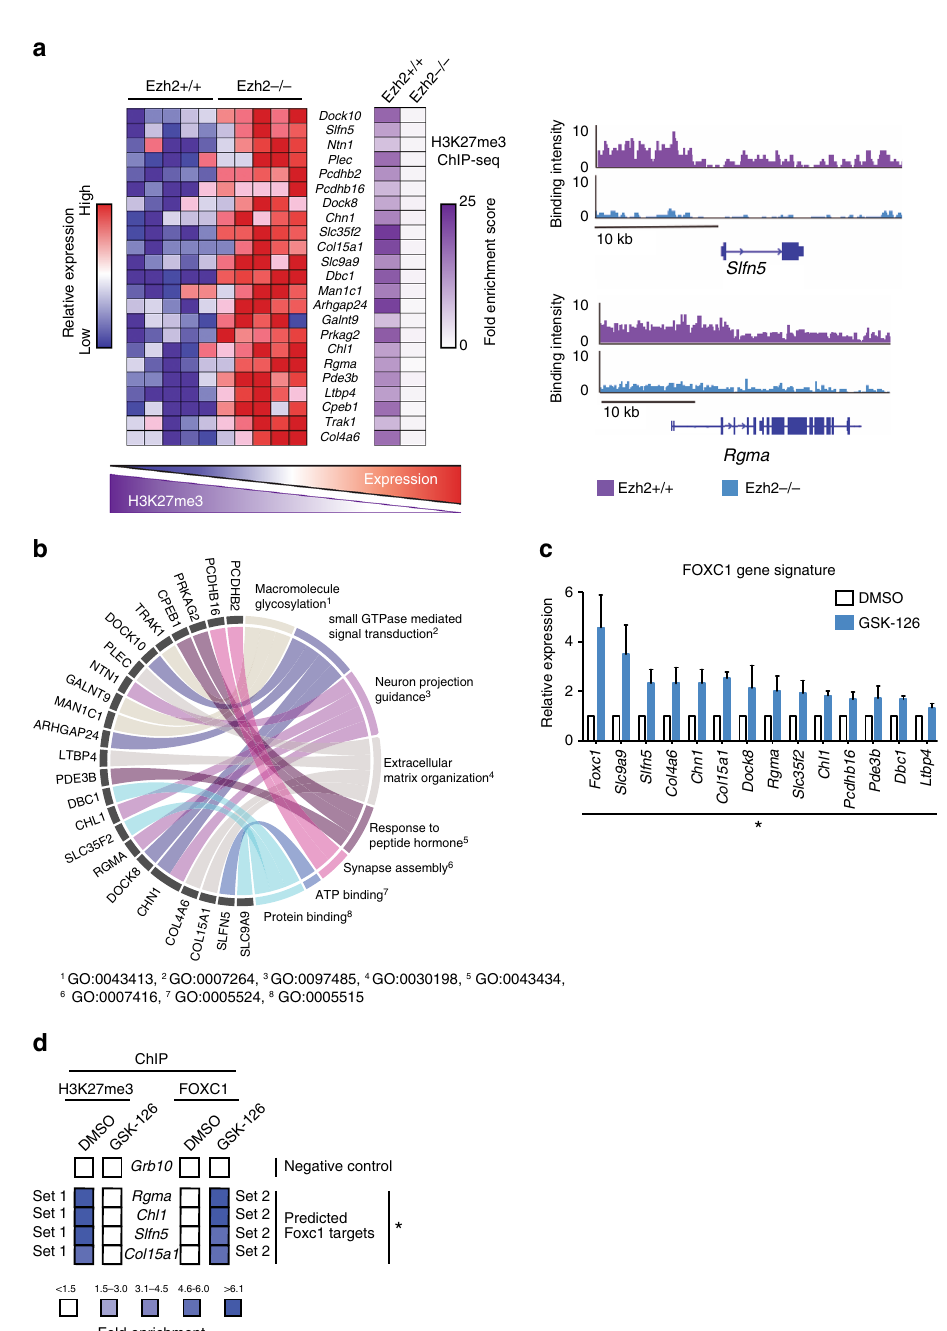
Fig. 4 Identi fi cation of anti-metastatic targets repressed by Ezh2. a Increased expression of Foxc1 predicted target genes coincides with reduced H3K27me3 enrichment status in Ezh2 − / − versus Ezh2 + / + tumours. Right panel shows a comparison of H3K27me3 binding intensity between Ezh2 + / + and Ezh2 − / − tumours for two known targets of FOXC1 activation, taken from the IGV browser. b Chord diagram of upregulated Foxc1 targets and their associated GO Biological Terms. The ChIP experiment is re fl ective of three different PyVmT cell lines. c Quantitative RT-PCR analysis of Foxc1 targets in PyVmT cells treated with GSK-126 (2 μ M for 72 h) or DMSO (vehicle). Data is an average of experiments performed in three different PyVmT cell lines. * p < 0.05 ( d ) Chromatin immunoprecipitation of H3K27me3 or Foxc1 in the presence or absence of Ezh2-mediated H3K27me3 pro fi les. Three different PyVmT cell lines were treated with or without GSK-126 (2 μ M, 72 h) or DMSO. Speci fi c primers to detect binding by H3K27me3 and Foxc1 were designed. * p < 0.05, two tailed t